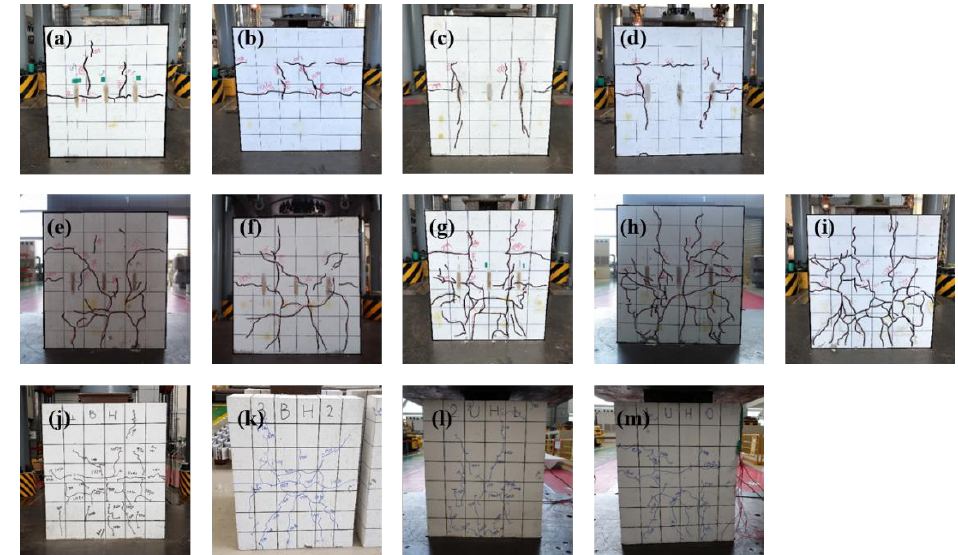
Figure 4. Failure Modes: ( a ) H-S; ( b ) UI-S; ( c ) UO75-S; ( d ) UO100-S; ( e ) H-Z130; ( f ) H-Z230; ( g ) UI- Z130; ( h ) UO75-Z230; ( i ) UO100-Z230; ( j ) H-C130; ( k ) H-C230; ( l ) UI-C130; ( m ) UO100-C230.